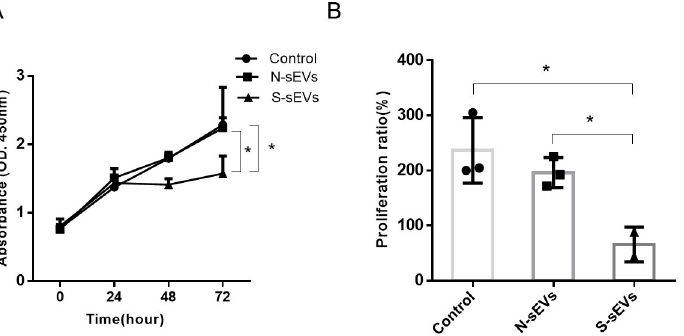
Fig 4. SUI-sEVs decreased the proliferation of fibroblasts. Fibroblasts were cultured with control medium or medium containing SUI-sEVs or medium containing non SUI-sEVs for 24, 48 and 72h, respectively. (A) Cell proliferation was determined with a CCK-8 assay. (B) The percentage of proliferative fibroblasts in three groups. SUI- sEVs significantly decreased the proliferation of fibroblasts after 72h when compared to the cells in control group and treated with the non SUI-sEVs. N = 3 in each group. Data represented means ± SD of 3 independent experiments. � t- test P value < 0.05.